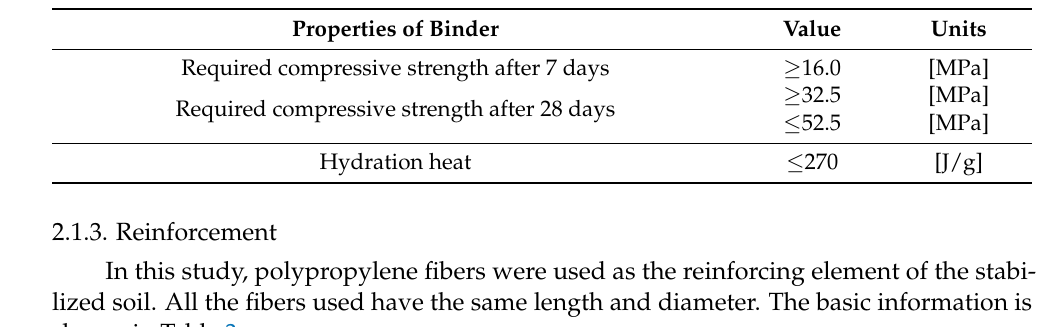
Figure 1. Grain size distribution curve of soil. Table 2. Properties of Blast furnace cement.